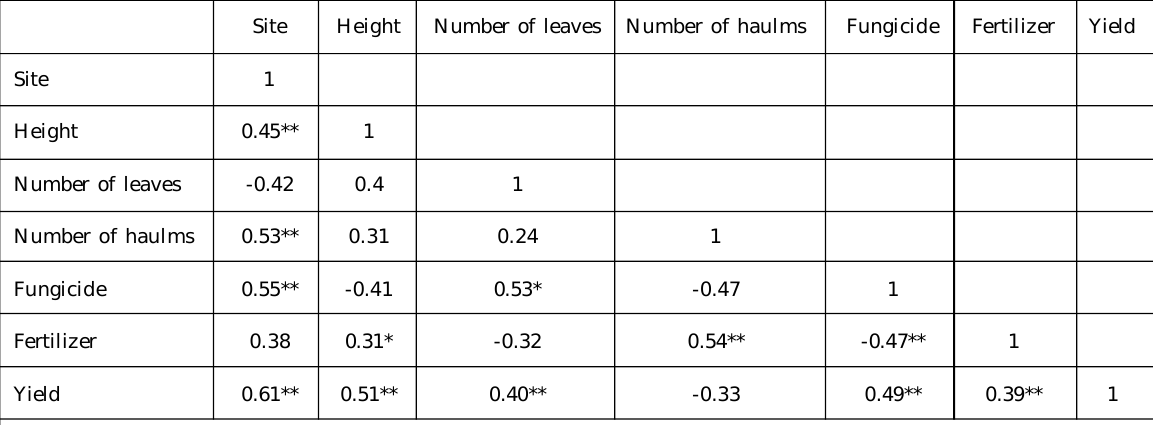
Table 7: Correlation analysis for the site, height, number of leaves, number of haulms, fungicide, fertilizer and yield of potatoes Site Height Number of leaves Number of